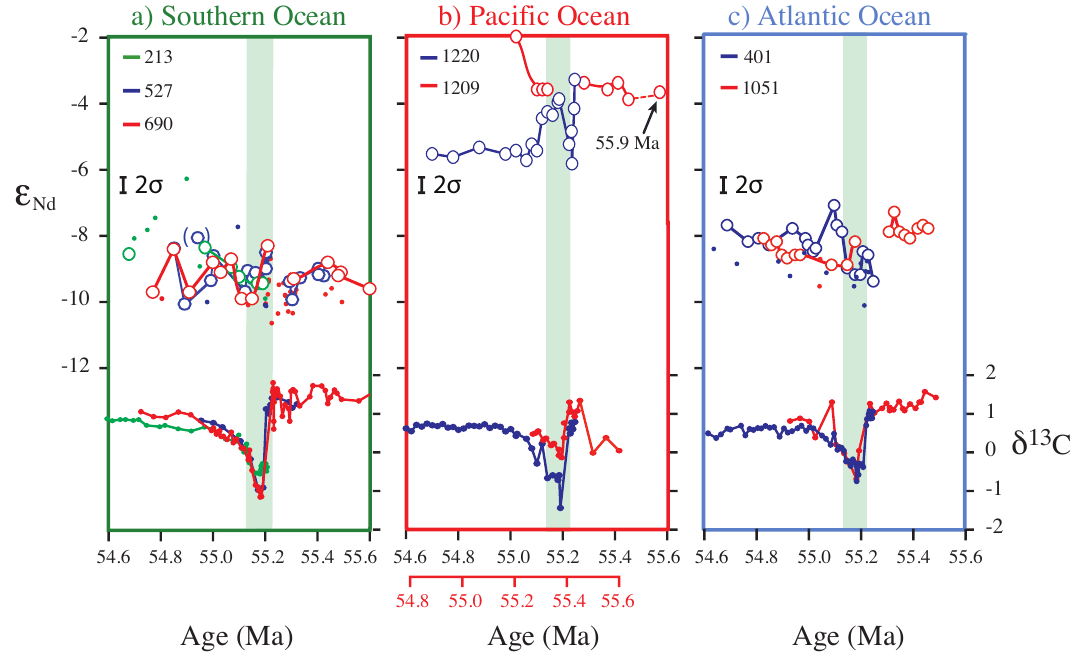
Figure 1. Nd and C isotope data ( ε Nd and δ 13 C) across the PETM from the Southern Ocean (a) , Pacific Ocean (b) , and Atlantic Ocean (c) . The sediment leach ε Nd are shown with circles and solid lines; the fish teeth/debris ε Nd from Thomas et al. (2003) are shown as dots. All data are presented on directly comparable scales for both ε Nd and δ 13 C. The sample ages are based on the δ 13 C age models. In (b) the age model of Site 1209B has been slightly adjusted (second x axis) such that the δ 13 C excursion coincides with the age of the PETM in the other cores. The shaded vertical bar indicates the timing of the PETM as defined by the CIE in the